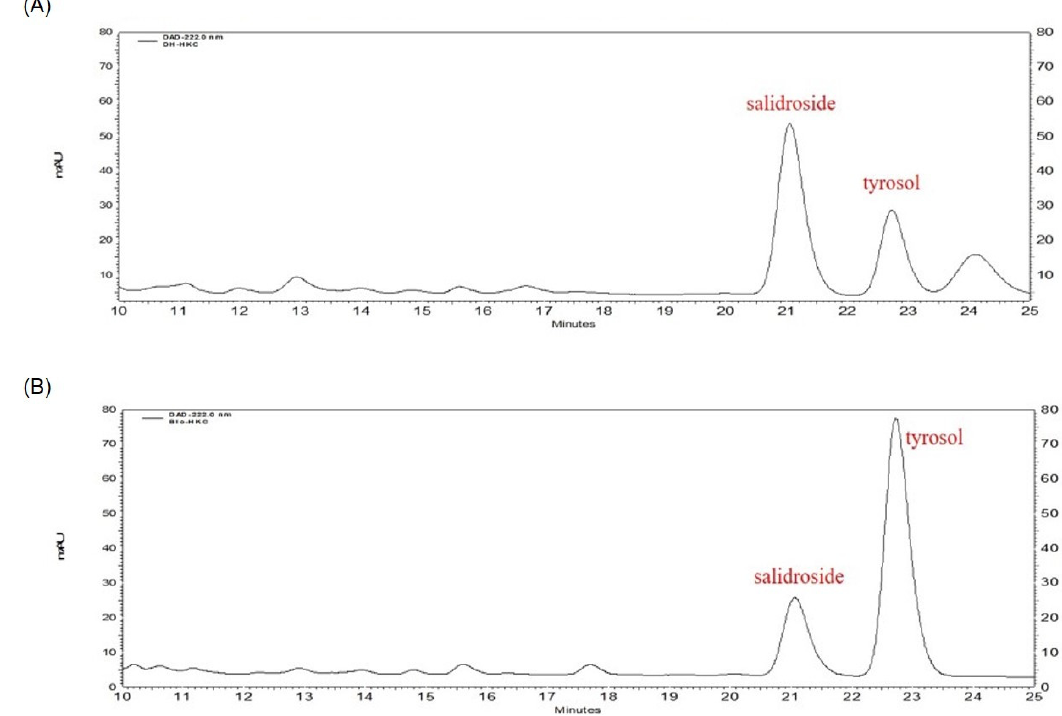
Table 1. Changes in the content of total polyphenols and flavonoids in R. sachalinensis extract fer ‐ mented with Bovista plumbea (Bio ‐ RSE) and R. sachalinensis extract (RSE).